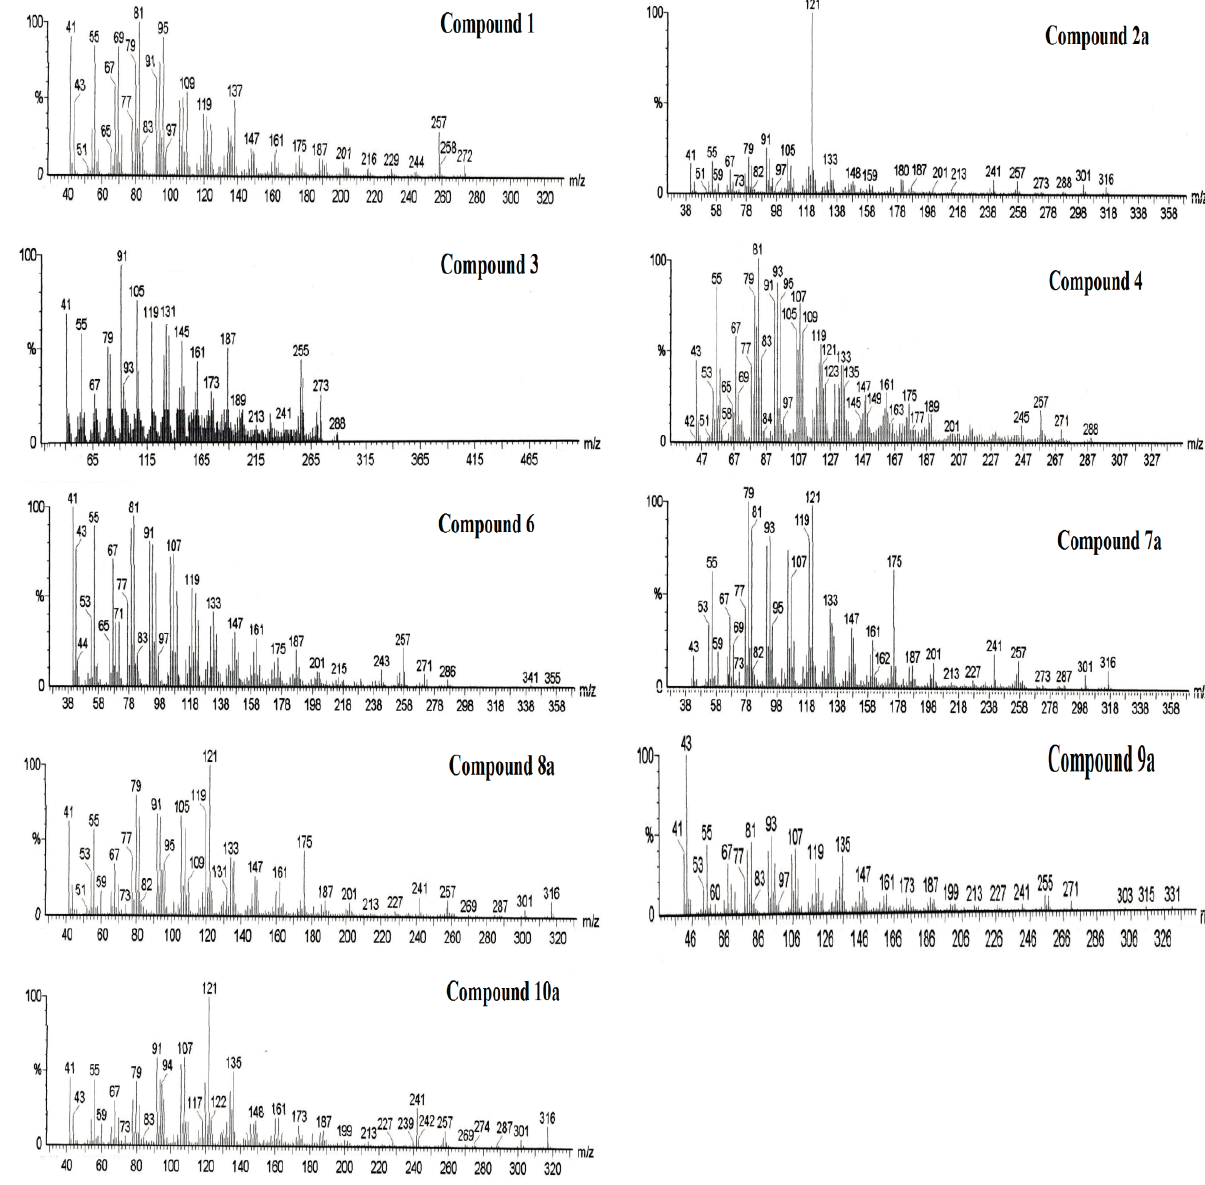
Figure 5. Mass spectra of the compounds 1 , 2a , 3 , 4 , 6 , 7a , 8a , 9a and 10a identified from the resin fractions of Austrocedrus chilensis trees inhibiting radial growth of the phytopathogenic oomycete Phytophthora austrocedri